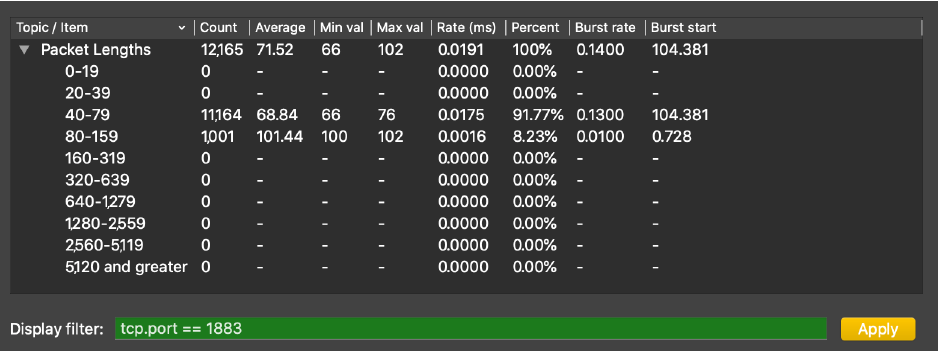
Figure 12. Screenshot of Wireshark packet length analysis of the experiment 3 MQTT